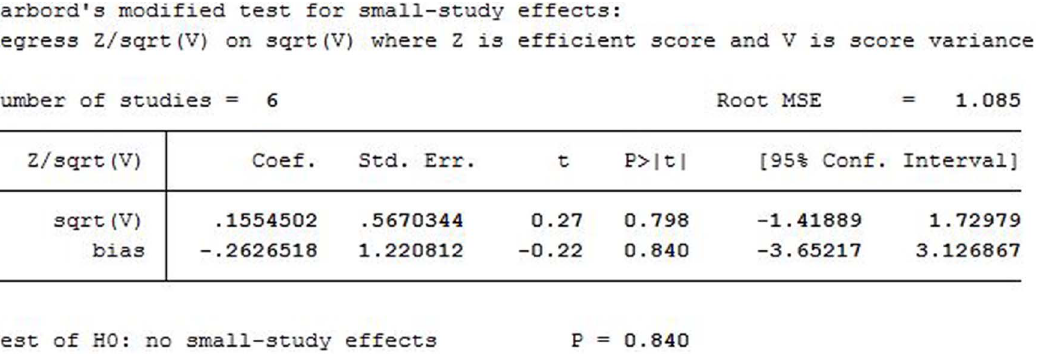
Figure 5. The result of publication bias in hardord way.